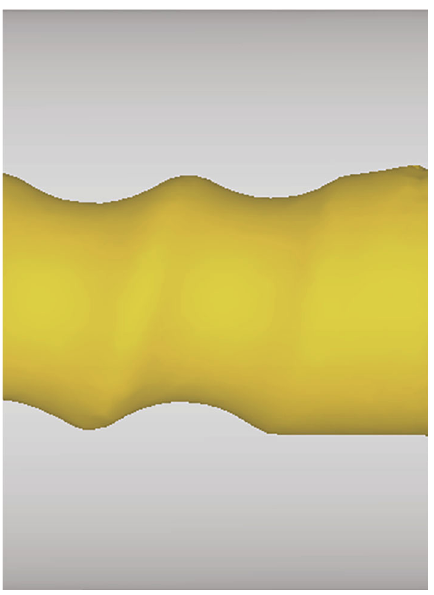
Figure 5: Screw channel fi